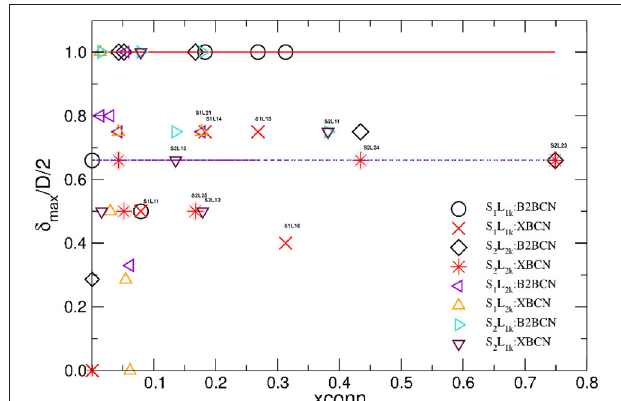
FIGURE 9 | Hyperbolicity δ max / D / 2 normalized by the half diameter D of the corresponding network for the brain-to-brain coordination networks (B2BCN) and their cross-brain subgraphs (XBCN) are plotted against the fraction xconn of links in XBCN relative to the entire B2BCN of various speaker-listener pairs. Large symbols are for the groups with the corresponding appointed speaker, while different triangles indicate the pairs with the not-appointed speaker. Full line at the top is the theoretical limit, while the dotted line indicates the hyperbolicity of single-brain